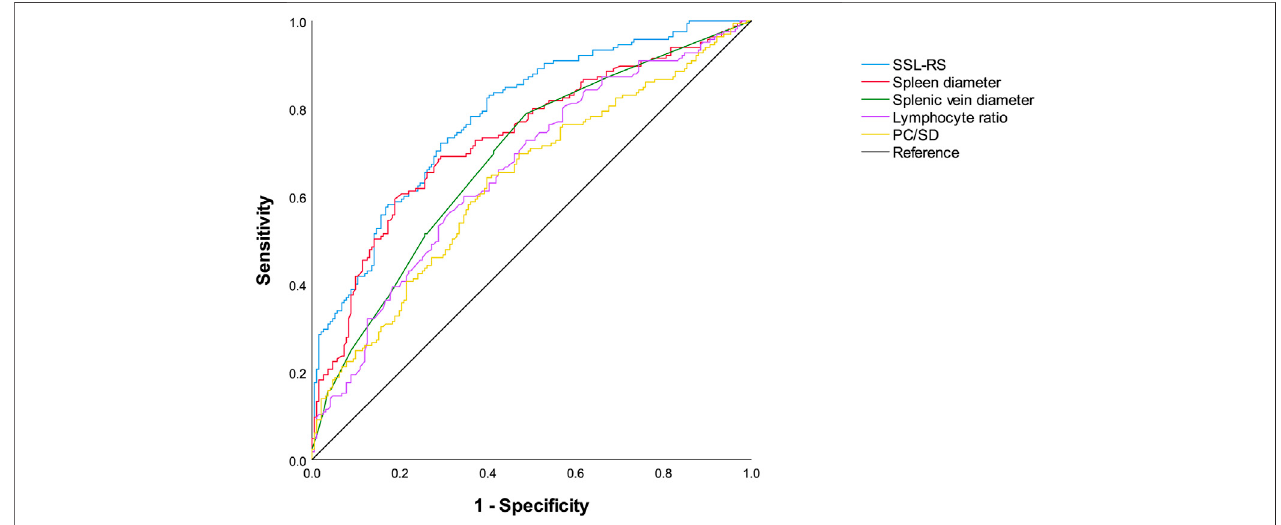
FIGURE 3 | Receiver operating characteristics curves of SSL-RS prediction model, spleen diameter, splenic vein diameter, lymphocyte ratio, and PC/SD for the diagnosis of red signs. SSL-RS prediction model, spleen diameter-splenic vein diameter-lymphocyte ratio-red signs prediction model; PC/SD, platelet count to spleen diameter